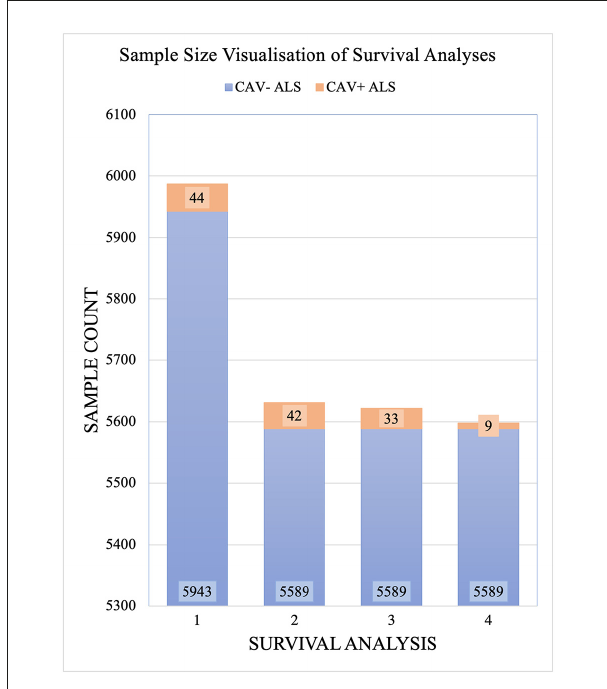
FIGURE3 Sample sizes for each Project MinE survival analysis. Samples are divided by those with CAV1/2 enhancer mutations (orange) and without (blue). Analyses are: [1] Full dataset including all rare mutations; [2] excluding C9orf72 samples; and [3] with CAV1 and CAV- samples only [4] with CAV2 and CAV- samples only. CAV- refers to patients who do not carry CAV1/2 enhancer mutations and CAV+ refers to those who